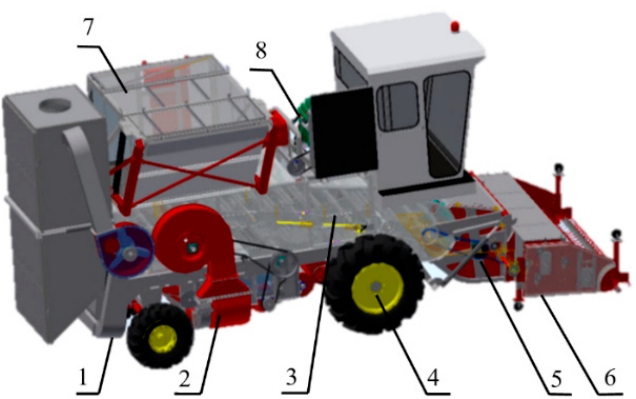
Figure 1. Overall structure of the peanut combine harvester. 1: Feeding device. 2: Cleaning device. 3: Multi-stage tangential-flow harvesting roller. 4: Running gear. 5: Conveying roller. 6: Pick-up and harvest table. 7: Fruit box. 8: Transmission system.